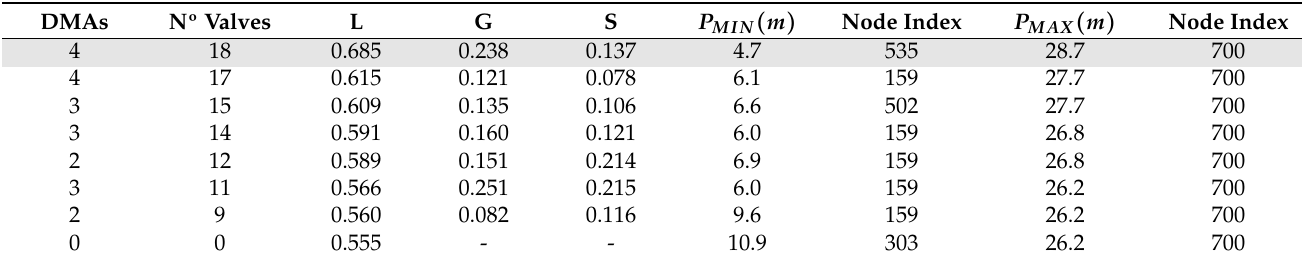
Table 6. Operating conditions of each solution obtained with Loss of resilience for MLN network. The gray background corresponds to the solution C represented in Figure 10.